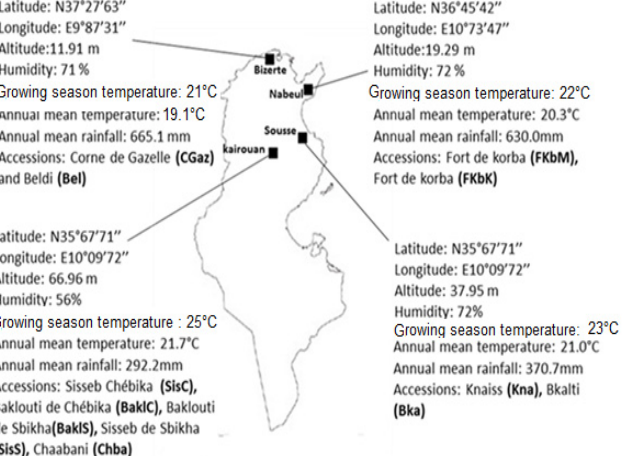
Figure 1. Geographical coordinates and annual climatic conditions in the four Tunisian sites where chili pepper accessions were collected.